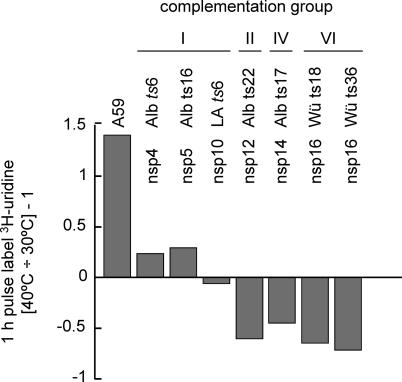
RNA Synthesis Phenotype of MHV-A59 ts MutantsRNA synthesis was determined using a 1 h pulse label with 3H-uridine in the presence of dactinomycin and cycloheximide, given to wt MHV-A59 and ts mutant virus-infected cells at 8 hpi with or without shifting from the permissive to the non-permissive temperature. The amount of incorporated 3H-uridine at 40 °C was divided by that at 30 °C and 1.0 was subtracted. The results represent the average of five separate experiments. A value of zero means the incorporation at the two temperatures was the same.